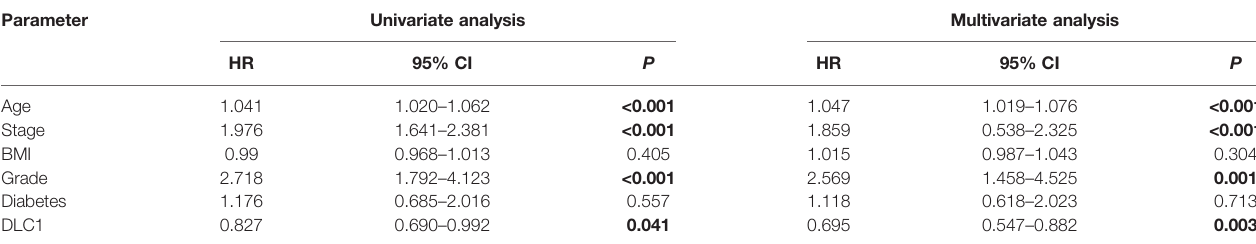
TABLE 3 | Univariate analysis and multivariate analysis of the correlation of DLC1 expression with OS among endometrial carcinoma patients. Parameter Univariate analysis Multivariate